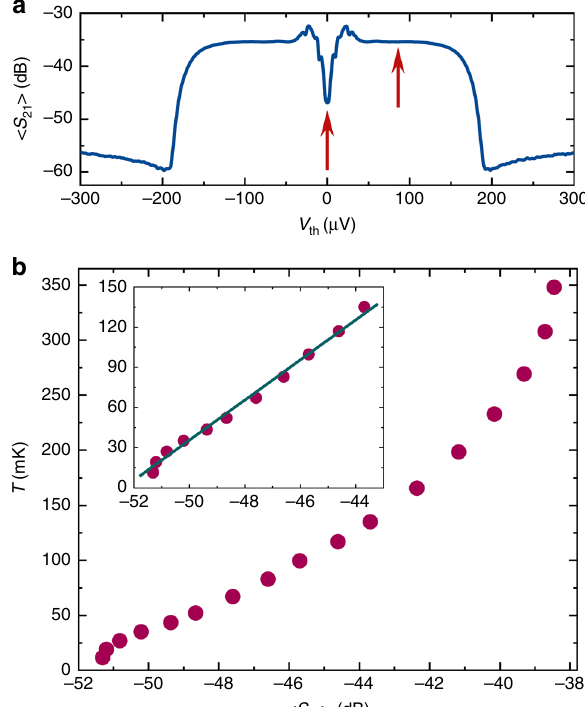
Fig. 2 The transmission measurement of the RF thermometer at (cid:2) 120 dBm input power. a Wide bias range transmission h S 21 i averaged over 100 repetitions at each bias point V at bath temperature T (cid:6) 100 mK. The th two red arrows indicate the working points for actual ZBA thermometry at V 0 and background measurement at V 85 µ V, respectively. b The th ¼ th ¼ thermometer calibration against the bath temperature T in equilibrium. The inset shows the low-temperature end together with the linear fi t used for the temperature fl uctuation